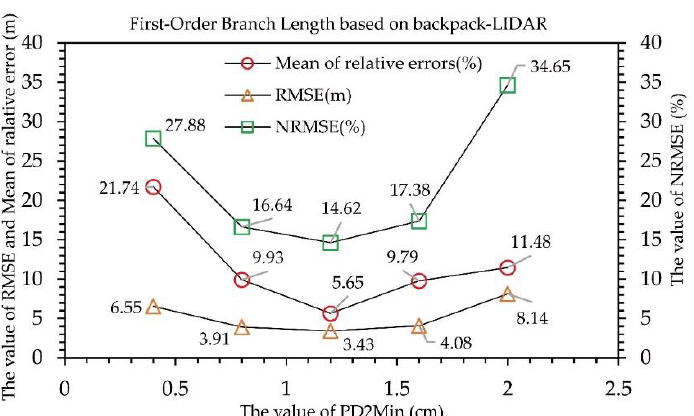
Figure 7. Uncertainty analysis of parameter PD2Min based on backpack-LiDAR. The best value of PD2Min is 1.2 cm for the backpack-LiDAR cloud point.